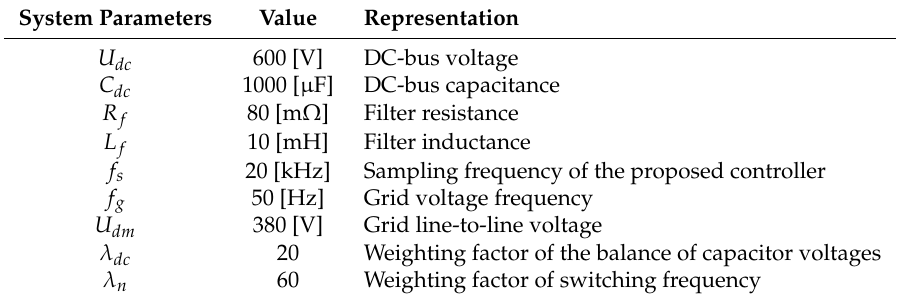
Table 3. Simulation